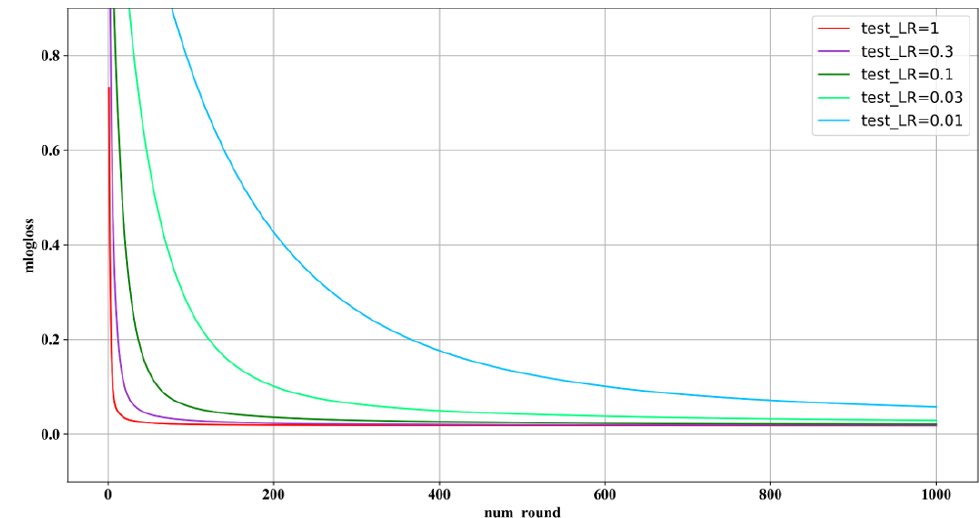
Figure 6. The number of estimates trees under different learning rates.